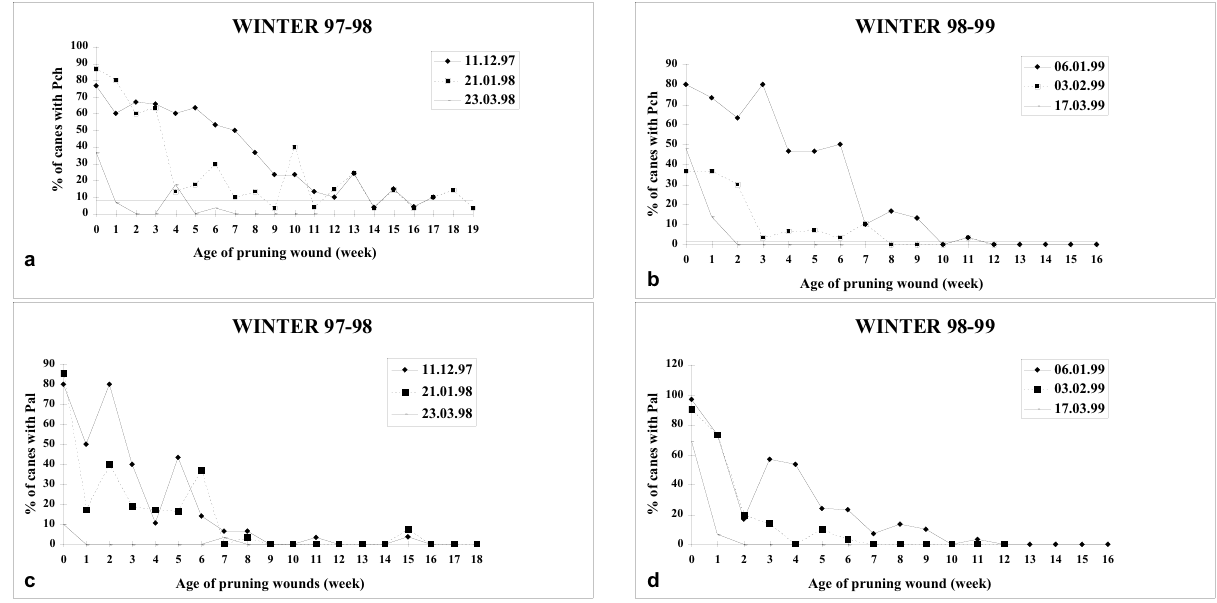
trapped.Fig. 2. Variation in the susceptibility of pruning wounds, expressed as percentage of wounds infected by Phaeoacre- monium chlamydosporum ( Pch ) (a, b) and P. aleophilum ( Pal ) (c, d) after inoculation with conidia at various pruning dates in two winters of experimentation. The horizontal line corresponds to the mean natural contamination of pruning wounds by P. chlamydosporum (a,